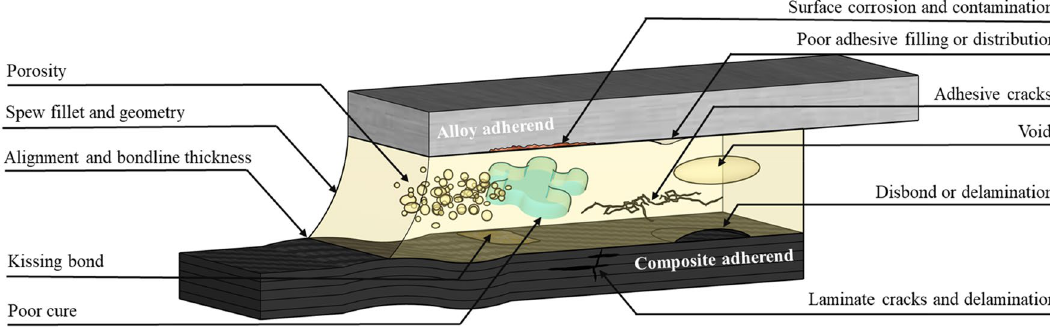
Fig. 5 An illustration of the typical defects and uncertainties in adhesively bonded